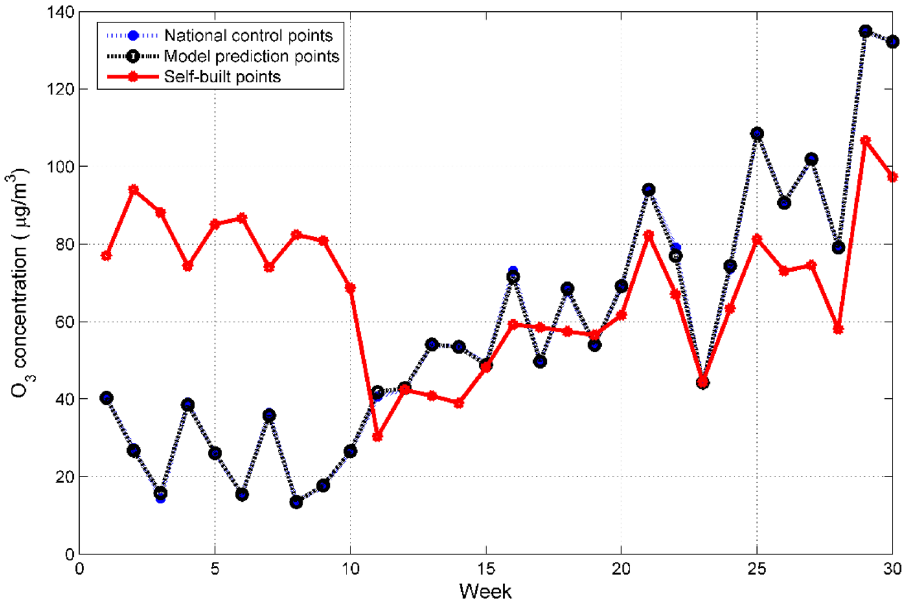
Figure 9. Comparison of the weekly average concentration of O 3 between national control points, RR-XGBoost model calibration points and self-built